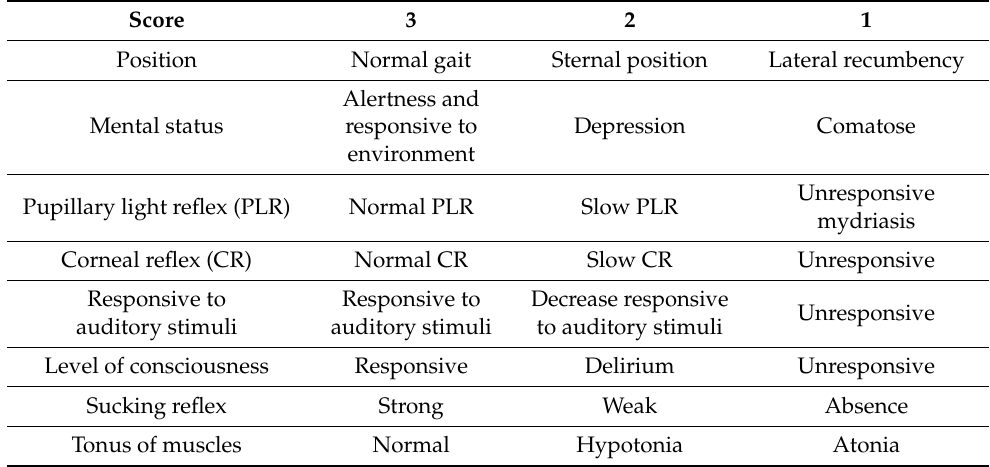
Table 1. Scoring variables and ranges of the neurological status evaluation in perinatal